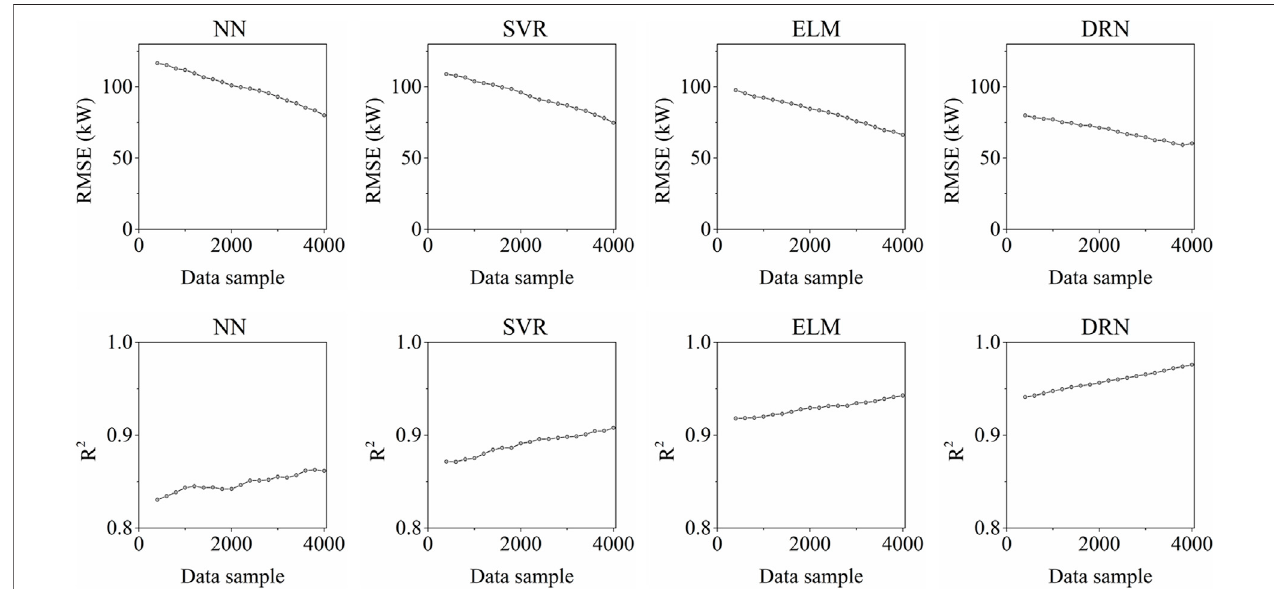
FIGURE 5 | Impact of training sample size on the prediction performance.